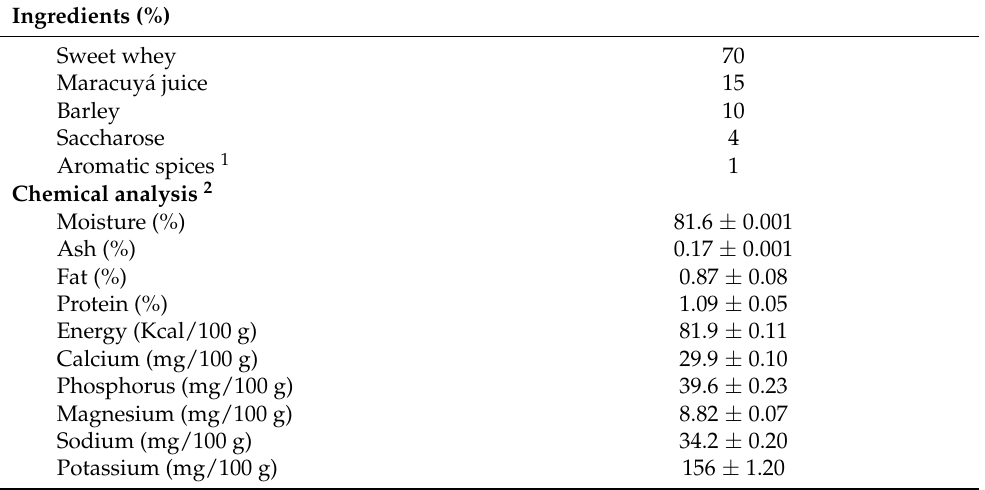
Table 1. Composition and nutritional analysis of the whey-beverage ( Colada